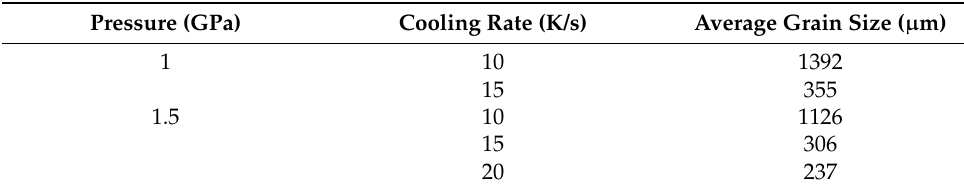
Table 2. The grain size of the Mg-1Sn-2.5Y alloy.